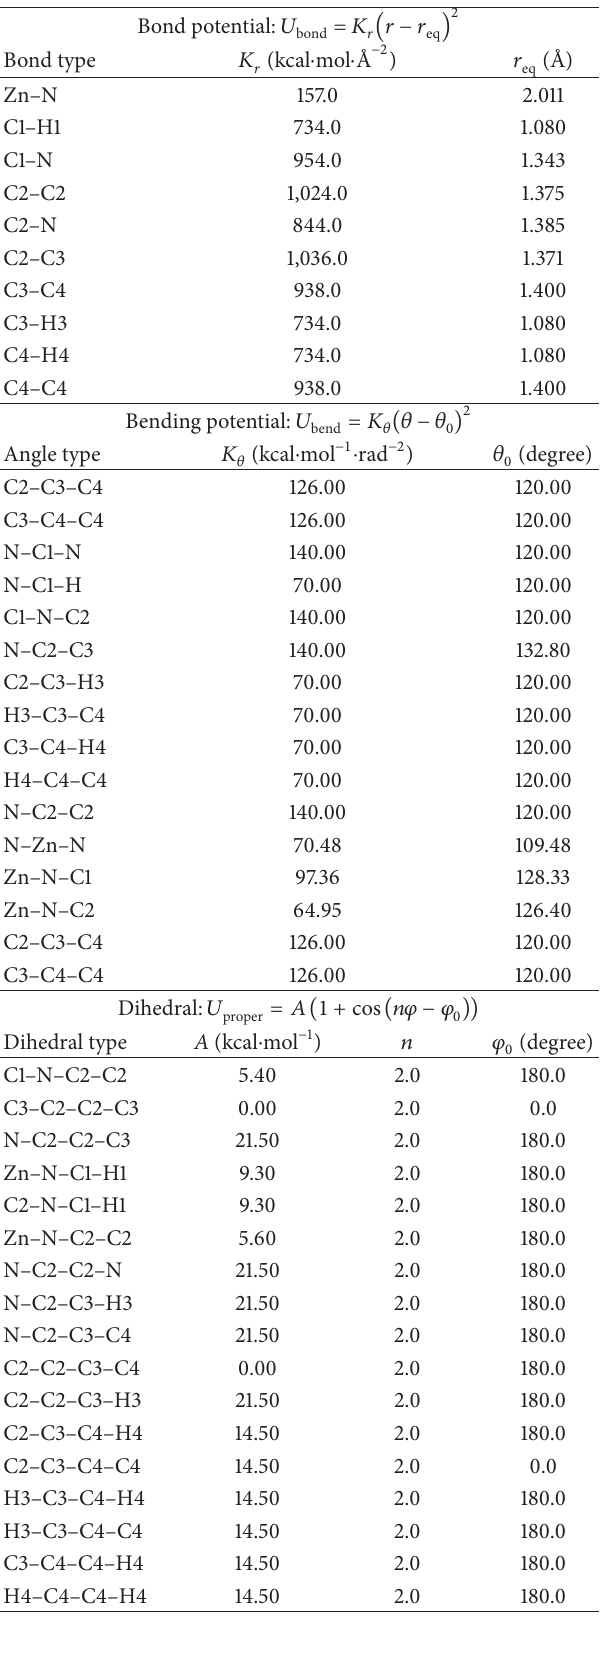
Table 2: The AMBER force field parameters for ZIF-11 flexible framework.